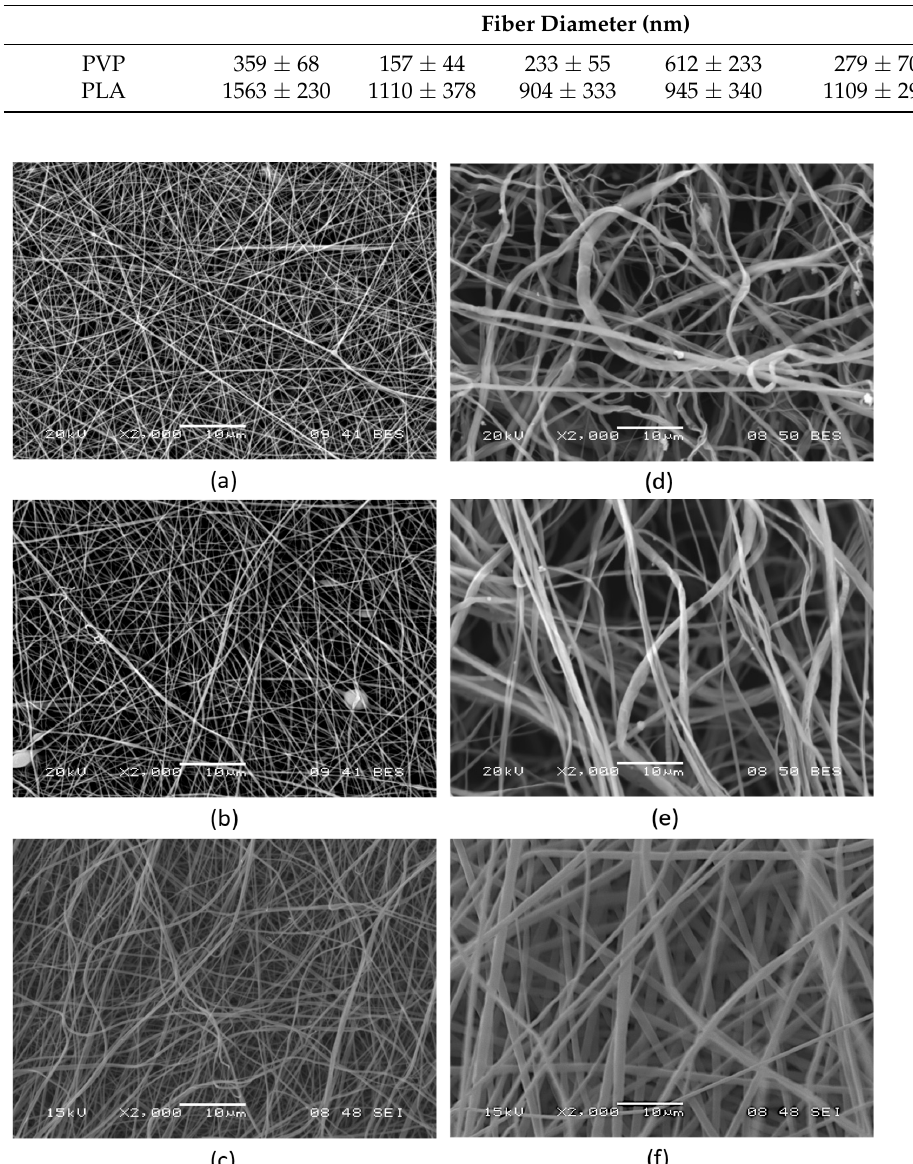
Figure 2. Scanning electron microscope (SEM) images, depicting the morphologies of nanofibrous PVP matrices containing ( a ) 10 wt% CrL; ( b ) 10 wt% RmL; and ( c ) a multi-layered PVP mask consisting of a CrL containing (10 wt%) bottom layer, a RmL containing (10 wt%) middle layer, and a nadifloxacin containing (3 wt%) top layer; as well as nanofibrous PLA matrices containing ( d ) 10 wt% CrL; ( e ) 10 wt% RmL; and ( f ) a multi-layered PLA mask consisting of a CrL containing (10 wt%) bottom layer, a RmL containing (10 wt%) middle layer and a nadifloxacin-containing (3 wt%) top layer and middle layer. Table 1. Average fiber diameter of different polymeric (PVP or PLA) nanofibers: nanofibers without loading agent, CrL, RmL, or nadifloxacin (NF); loaded nanofibers; and multilayered mask built up from enzyme and antibiotic loaded nanofibrous layers. The diameters of the fibers were determined via software analysis of SEM images. In each case, the average fiber diameters were calculated by measuring 100 independent fiber diameters.